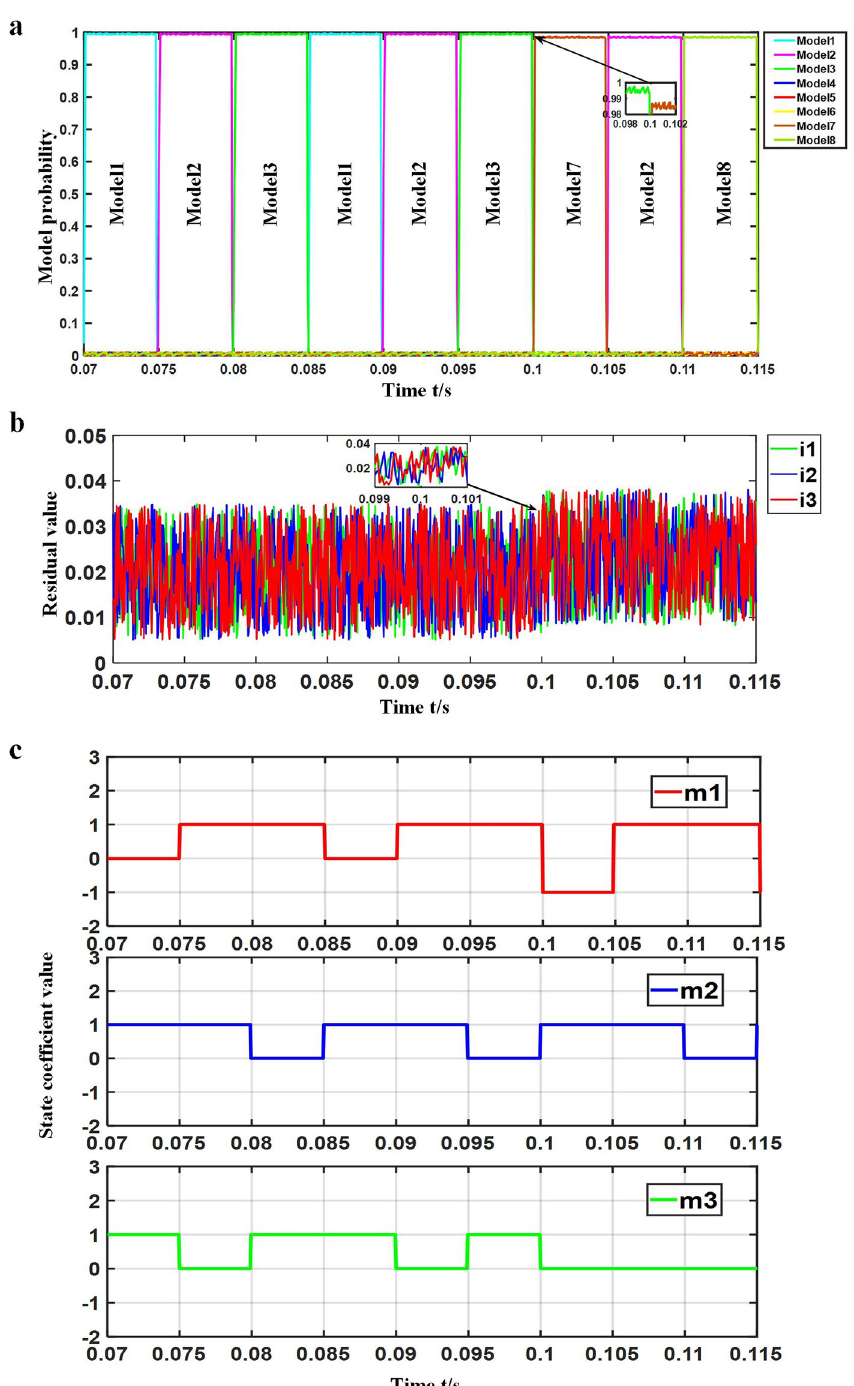
Fig 11. Simulation waveform of multiple faults occurring at the same time. (a) Probability change waveform of each model (b) Current residual waveform of each (c) Observation waveform of m 1 , m 2 and m 3 .